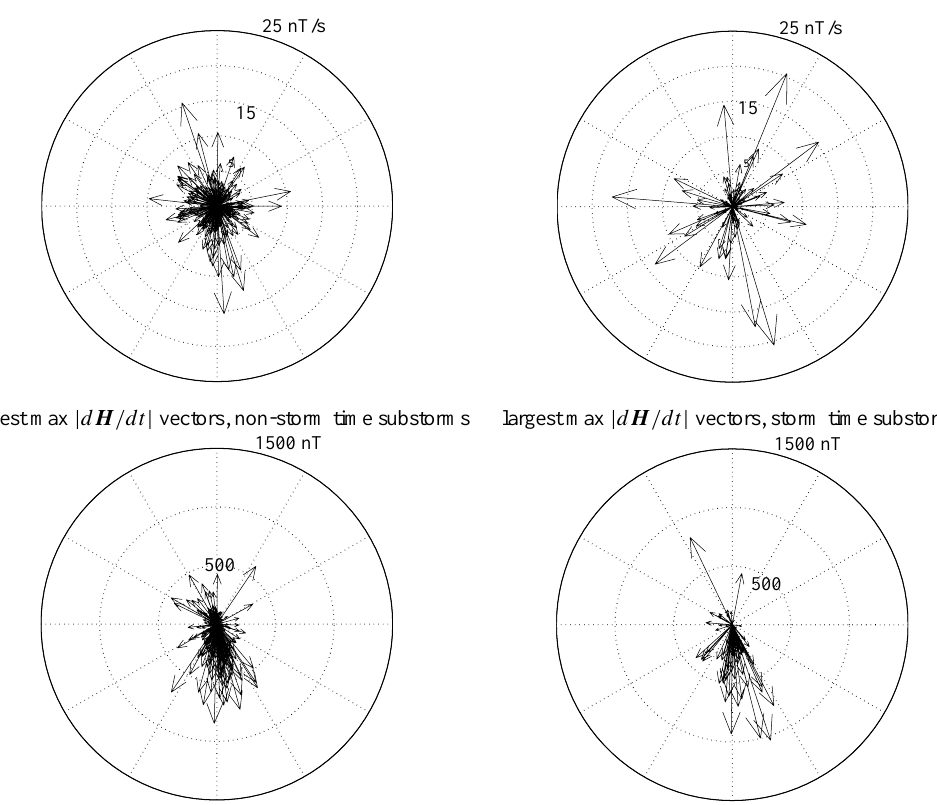
Fig. 10. Top figures are the largest max | d H /dt | vectors for the maximum site, left = non-storm time (469 substorms), right = storm time (83 substorms). Bottom figures are the simultaneous median subtracted H vectors, left = non-storm time (466 substorms), right = storm time (81 substorms). (Several outliers were removed in order to be able to display the result clearly. Magnetic north is to the top of the page and east to the